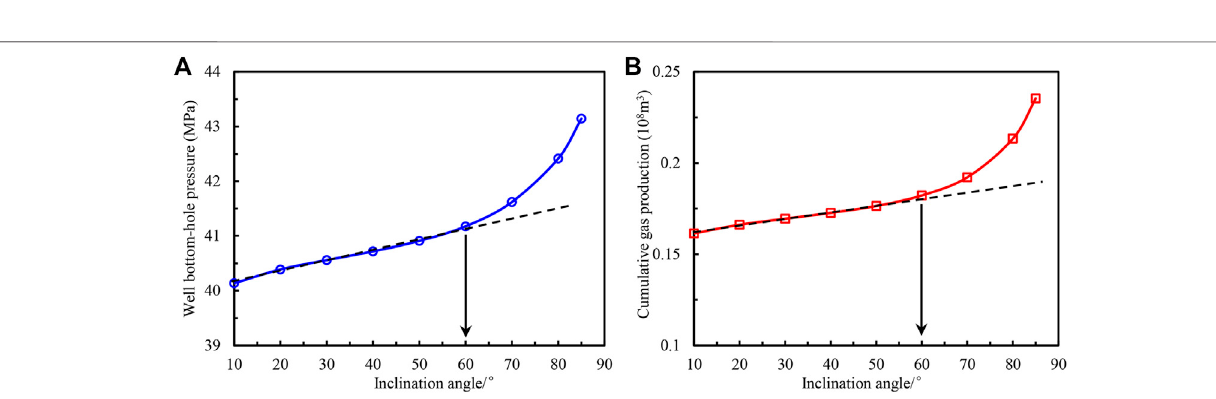
FIGURE 13 | (A) bottom-hole fl owing pressure and (B) cumulative gas production rate of the second formation for diverse penetrated inclination angles in the fi rst layer and second formation.